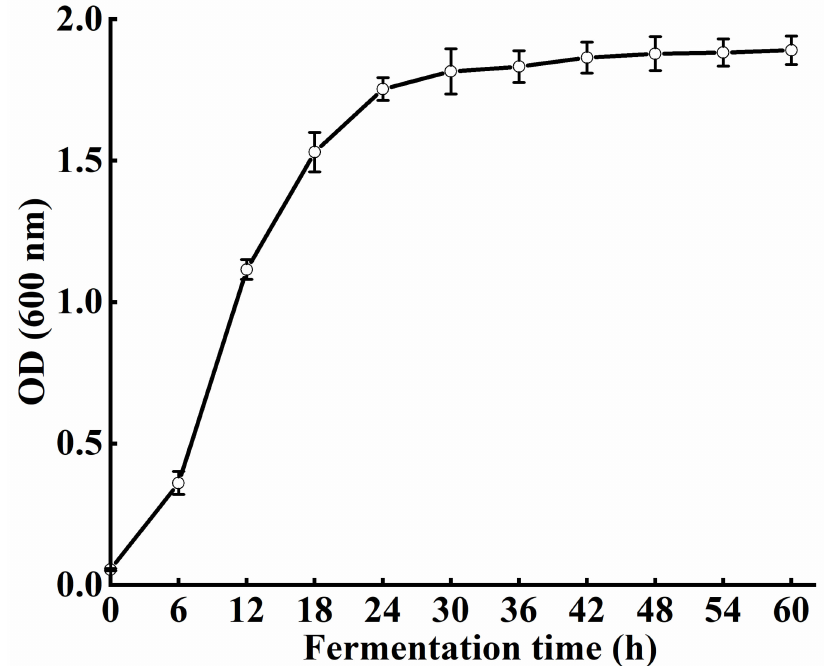
Figure 1. The growth curve of the S. xylosus A2.